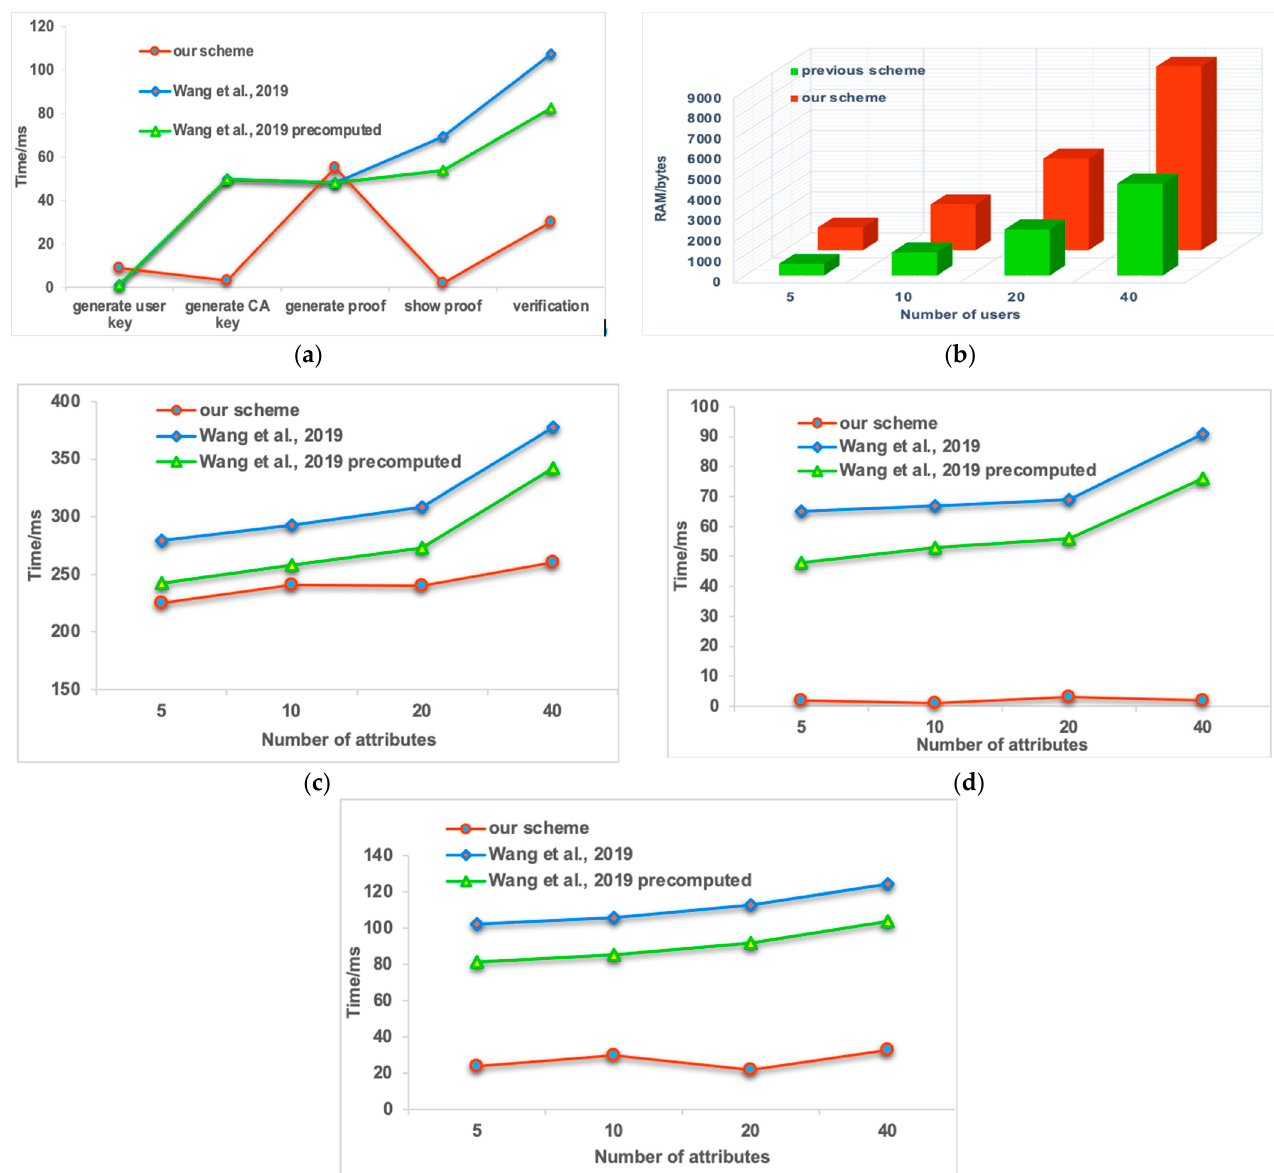
Figure 4. Analysis of scheme efficiency [21]. ( a ) Comparison of calculation efficiency; ( b ) comparison of certificate storage space; ( c ) multi attribute efficiency comparison; ( d ) efficiency comparison of certificate presentation; and ( e ) verify the efficiency of the certificate.